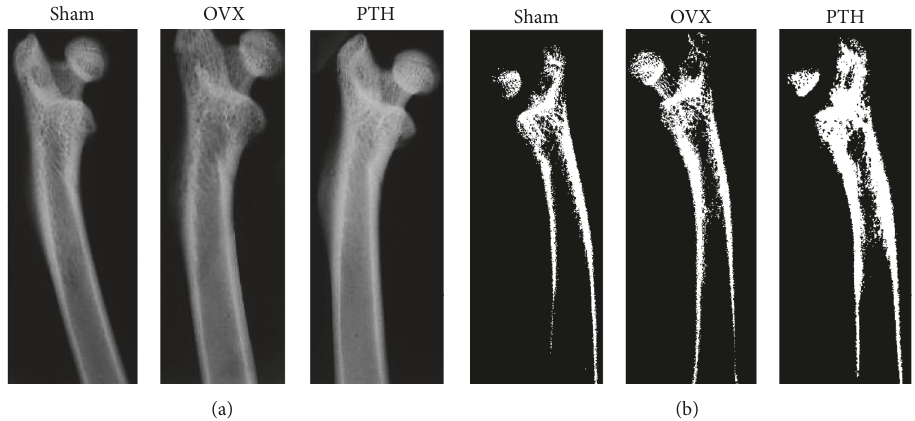
Figure 6: Therapeutic treatment experiment: example of microradiography of Sham control, OVX and OVX treated with PTH femurs bones at 11-weeks postoperation. (a) Representative radiographs (b) Radiographs following threshold analysis. PTH treatment increased the trabecular bone compare with the Sham and the OVX controls. Slides were conducted with FAXITRON (a cabinet X-ray system, Hewlett-